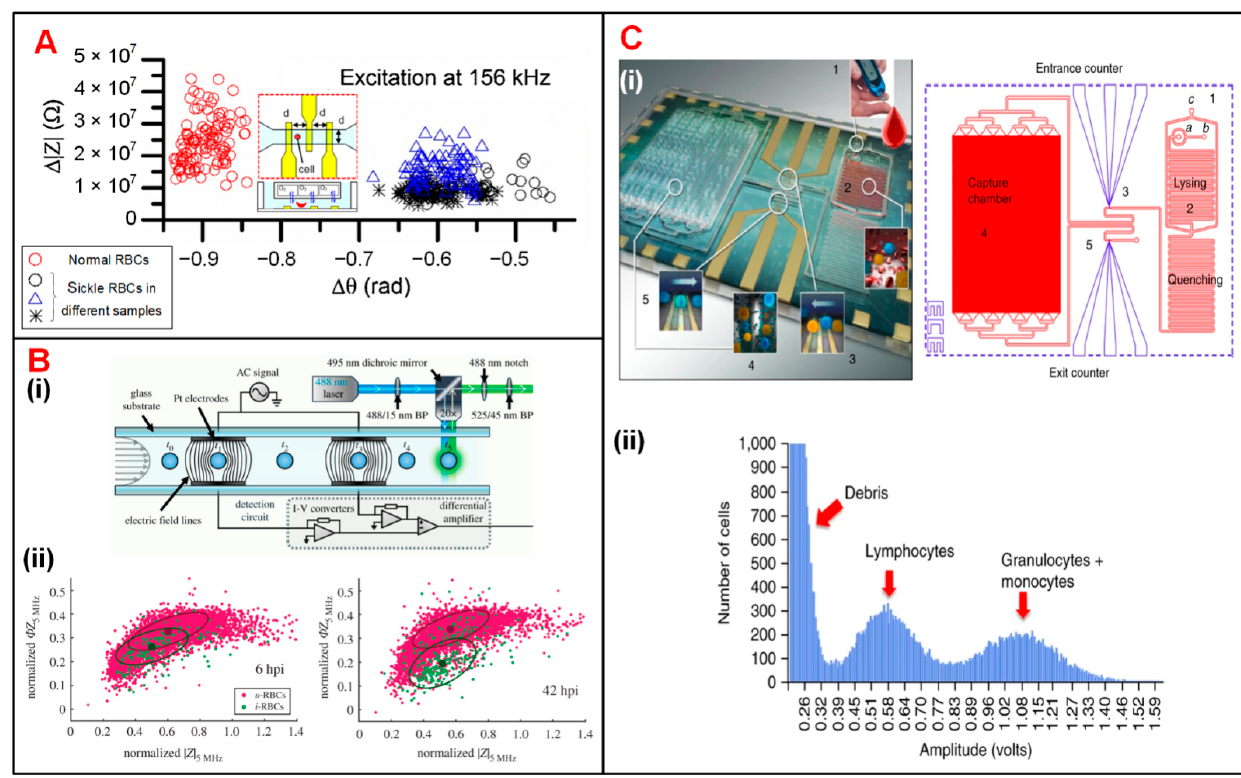
Figure 4. Blood cell analysis using IFC devices. ( A ) Measurement of Δ |Z| vs. Δθ for normal and sickle RBCs at 156 kHz. Reproduced from [110] with the permission from Elsevier. ( B ) ( i ) Schematics of a IFC device integrated fluorescence detection. ( ii ) Measurement of normalized phase ( Φ Z 5MHz ) vs. amplitude (|Z 5MHz |) at 6 h and 42 h after RBC infection. u-RBCs and i-RBCs stand for uninfected and infected RBCs. Reproduced from [114] with the permission from Royal Society. ( C ) ( i ) Photograph and layout of the differential immunocapture biochip. ( ii ) Pulse amplitudes of recorded impedance signals showing the size distribution of cells. Lymphocytes and granulocytes + monocytes are two groups of distinct populations of leukocytes. Reproduced from [111] with the permission from Springer Nature.